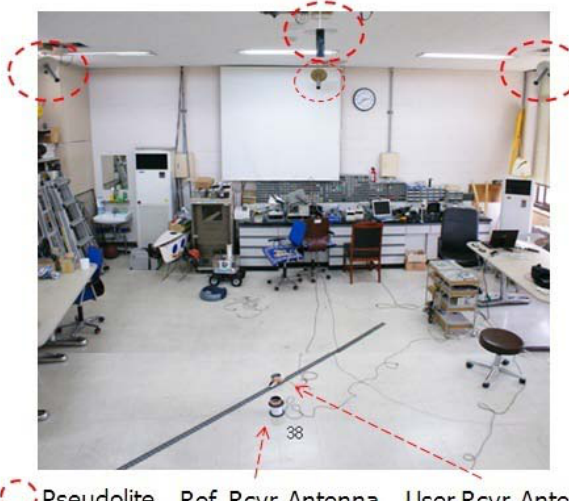
Figure 13. SNUGL indoor PL navigation